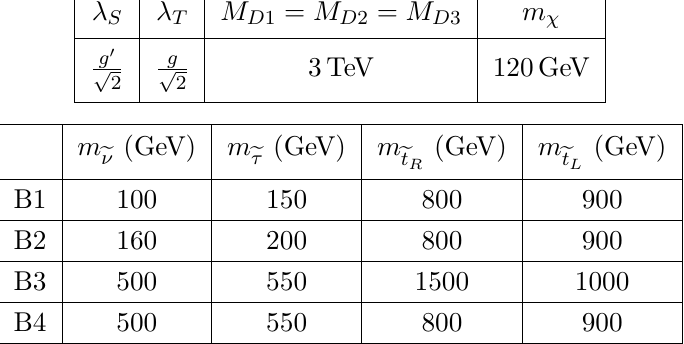
Table 3 . The benchmark scenarios